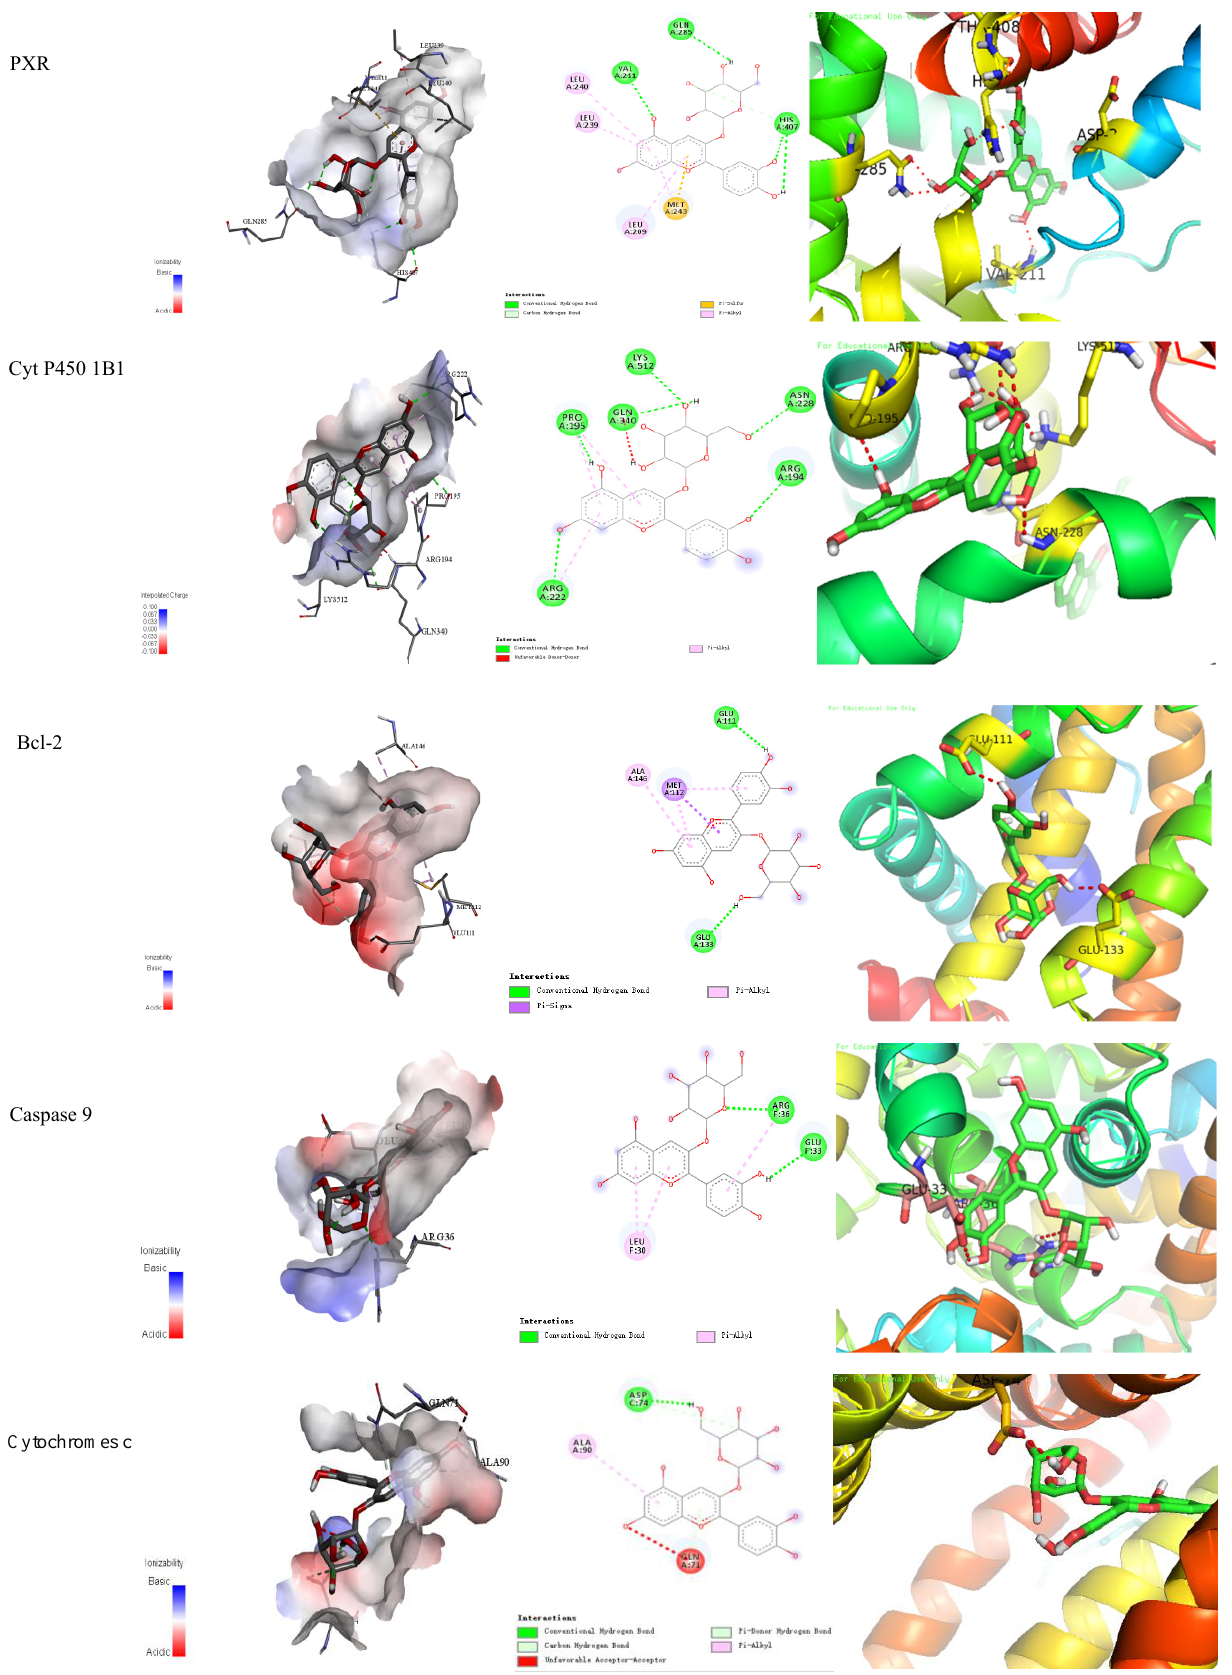
Figure 3. Cyanidin- 3 - O -glucoside-proteins docking combination . Table 4. Molecular docking mode for Cyanidin- 3 - O -glucoside with PXR, Bcl-2, Caspase 9, and Cy- tochrome c.